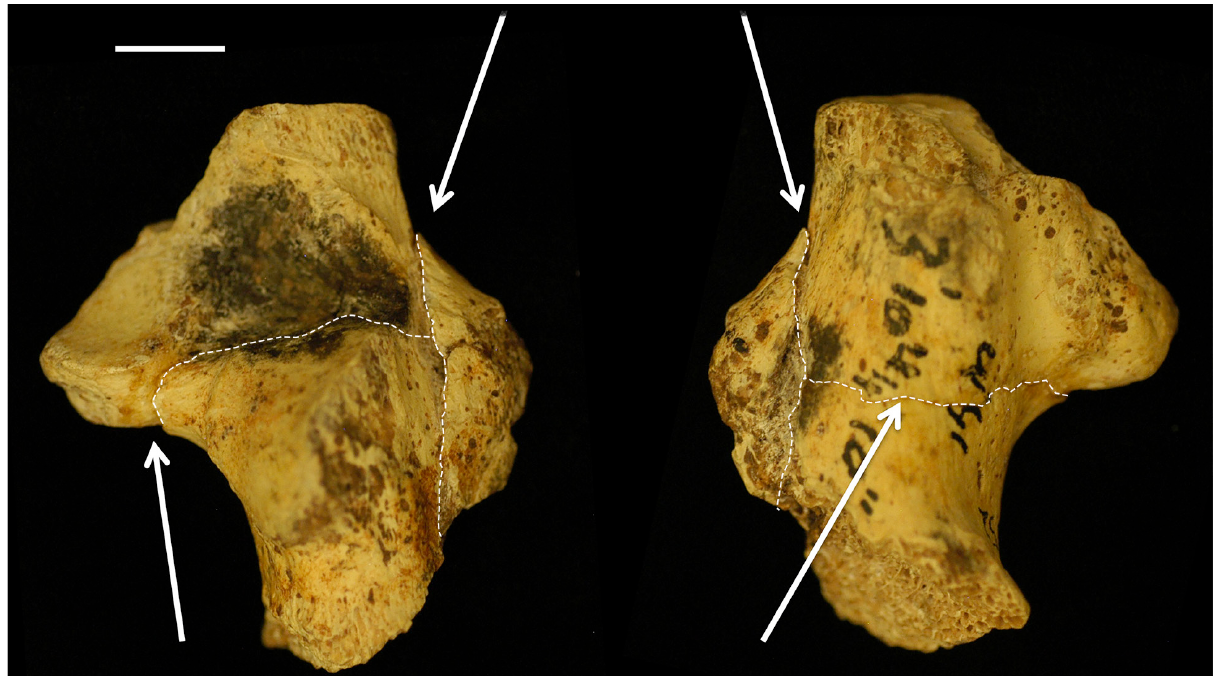
Figure 1: (Left) Dorsal and (right) plantar views of StW 352. Arrows and dashed lines highlight repaired breaks through the body of the calcaneus and separating the peroneal trochlea from the rest of the calcaneus. Note the lack of continuation of the ‘horizontal’ break through its intersection with the ‘vertical’ break in the